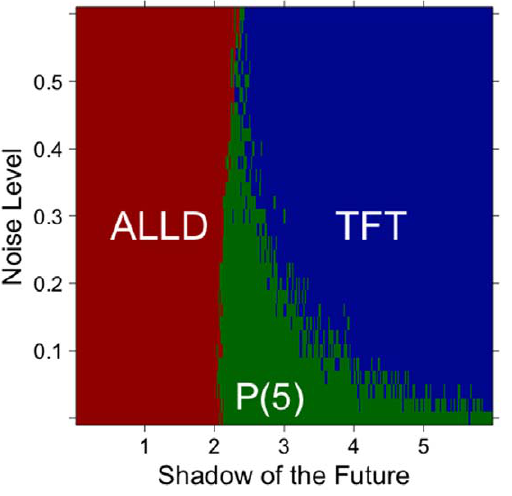
Figure 5. Strategies with the highest average score, as a function of the level of noise. Noise refers to the probability that a player’s strategy does not correspond to its DNA. In other words, it weakens the correlation between specific traits and strategy. The higher the level of noise, the more players’ strategies are defined indepen- dently of their traits. Prejudiced strategies perform well for low levels of noise and intermediate values of the shadow of the future. For high levels of noise, however, inferences drawn by prejudiced strategies become less and less reliable. The results are based on one hundred simulations with 50% TFT, 50% ALLD and one prejudiced player.